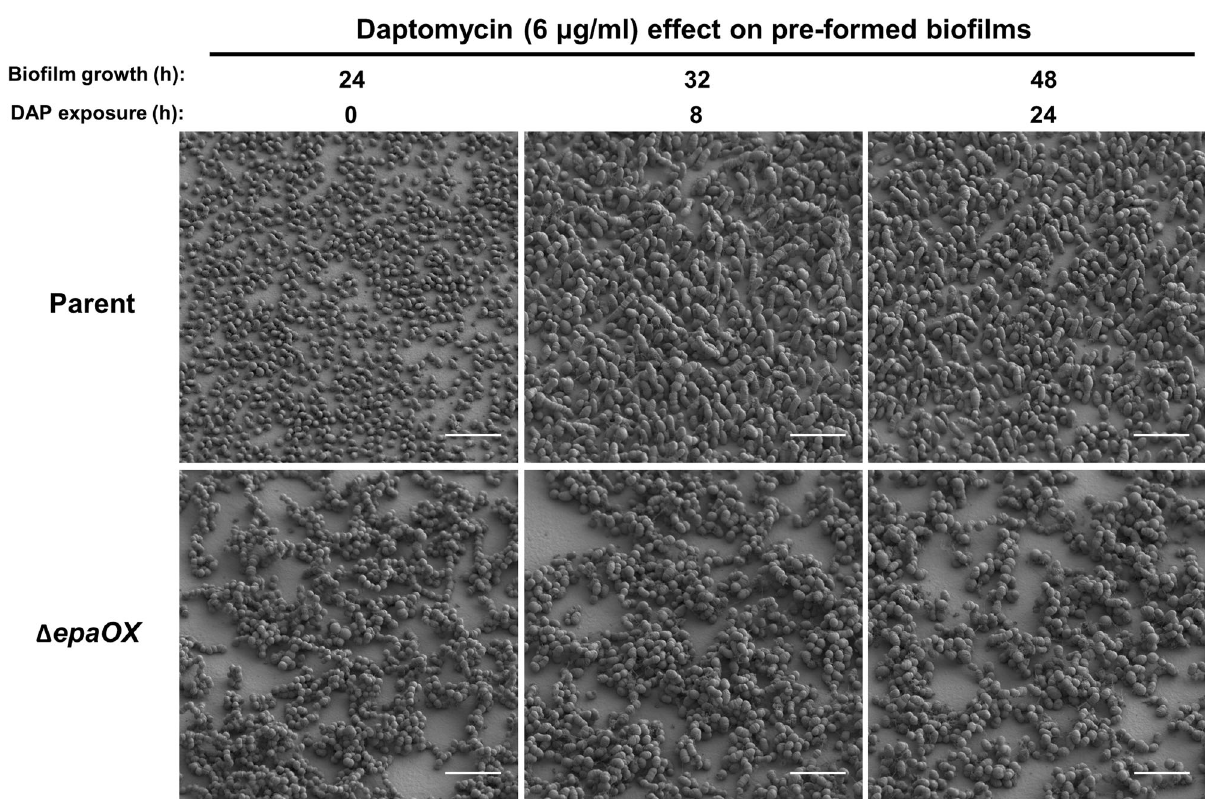
Fig. 3 Daptomycin effects on pre-formed E. faecalis bio fi lms. Experiments were performed as detailed in Materials and Methods. E. faecalis parent and Δ epaOX strains were cultured on Aclar membranes for 24 h in CBRs without antibiotics to establish bio fi lms. Daptomycin (DAP) was then added to the culture medium at a concentration of 6 µg/ml and the effects on the pre-formed bio fi lms were assessed after 8 and 24 h of antibiotic exposure. Low-voltage scanning electron microscopy (SEM) was performed to examine bio fi lm architecture (scale bars, 5 µm). Representative images are shown from experiments performed in triplicate with similar